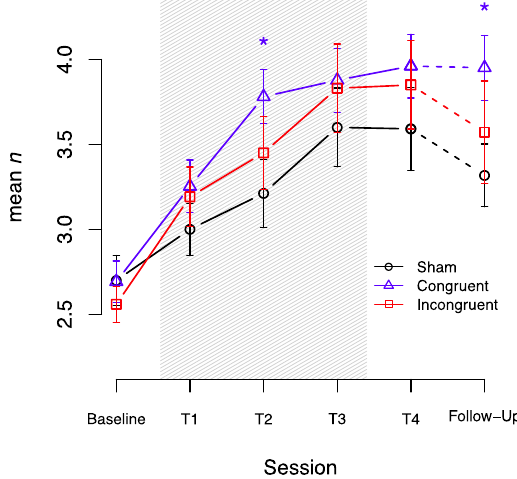
Figure 1. Adaptive n-back training (mean n) across sessions with T1 – T3 combined with anodal tDCS during one week. At T4, the adaptive n-back was trained without tDCS. Follow-up sessions were performed without tDCS. Shading indicates application of tDCS. Error-bars represent the standard error (SEM). * Indicates significant t-tests (p <